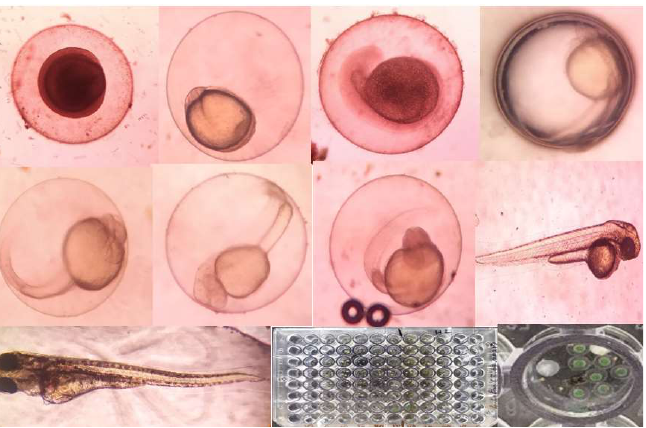
Figure 11. Control images of eggs and embryos of Zebrafish (not exposed to silver nanoparticles) at 120 hpf. 2.11. Toxicity Studies on Embryonic Zebrafish Exposed to Pantoea stewartii-Mediated Ag NPs Table 7. Toxicity assay of Pantoea stewartii -mediated Ag NPs on embryos. At 48 h after treatment, Pantoea stewartii -mediated Ag NPs showed low (less than 70%) embryo mortality. There was no mortality in controls and groups treated with lower concentrations (10 and 20 µ g/mL). The LC 50 , LC 90 , and χ 2 values were